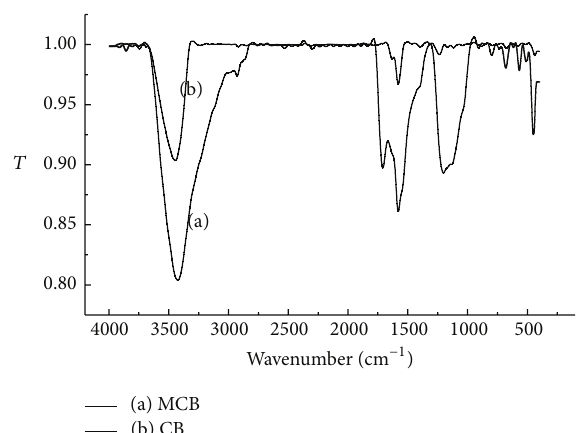
Figure 2: Infrared spectrum of MCB and